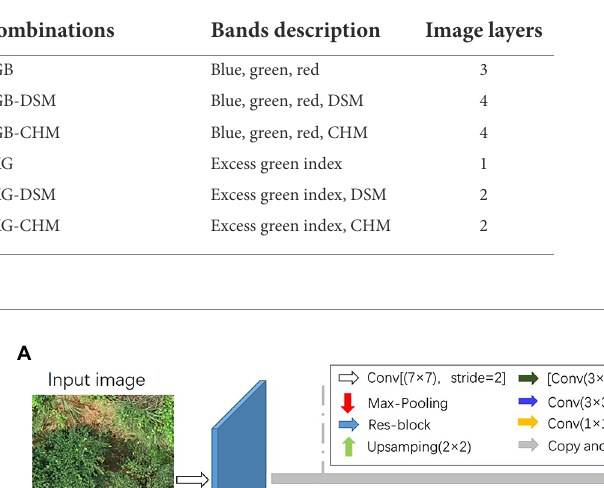
TABLE 2 Combination of different images for ResU-Net training.